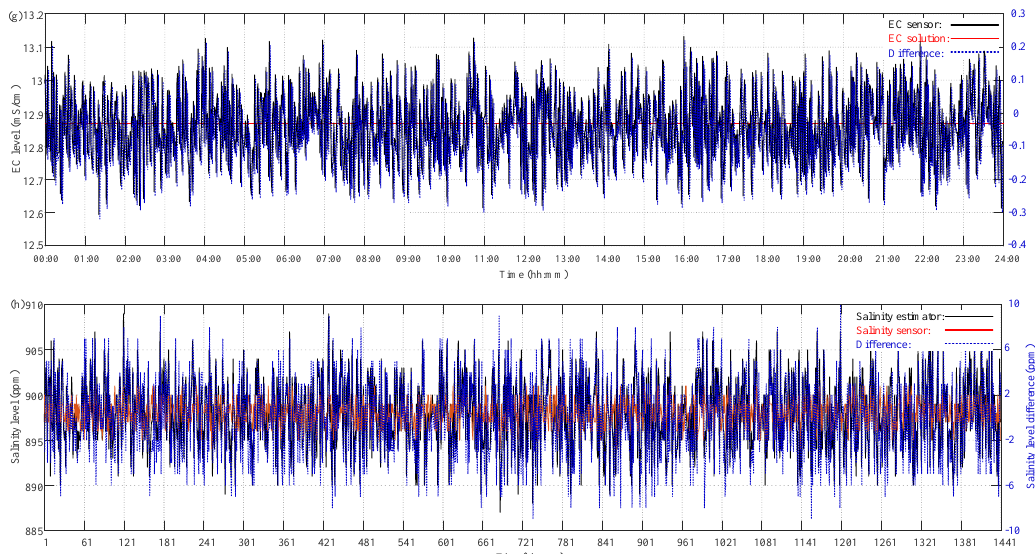
Figure 7. The 24 h measurement results of pre-calibration process: ( a ) DS18B20 temperature sensor vs. HEL-711 RTD; ( b ) pH sensor vs. pH 4.4 buffer solution; ( c ) pH sensor vs. pH 6.86 buffer solution; ( d ) pH sensor vs. pH 9.0 buffer solution; ( e ) DO sensor vs. FOPTOD ODO; ( f ) EC sensor vs. EC 1413 μS/cm solution; ( g ) EC sensor vs. EC 12.88 mS/cm solution; and ( h ) salinity estimation vs. Vernier salinity sensor.